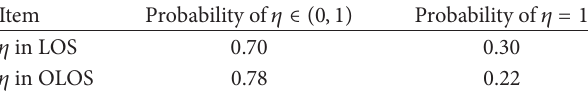
Table 5: Statistical probability of 𝜂